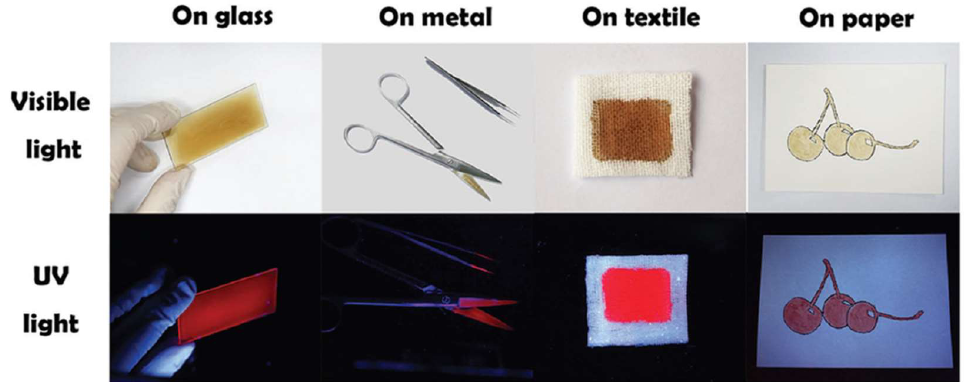
Figure 9. Images of cellulose-based PS 12 on different substrates. Reprinted with permission from Ref. [69]. 2008, Elsevier.